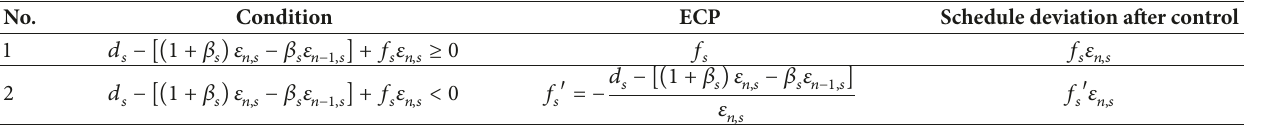
Table 3: Control effects in different